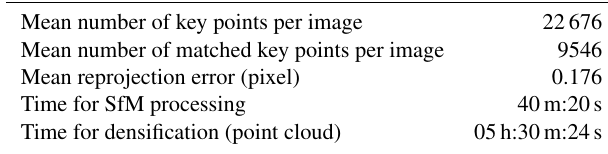
Figure 5. The captured image positions around the reconstructed castle hill (a) and the point clouds obtained by RPAS technology (b) (see top view in Fig. 3.) Table 1. Image processing